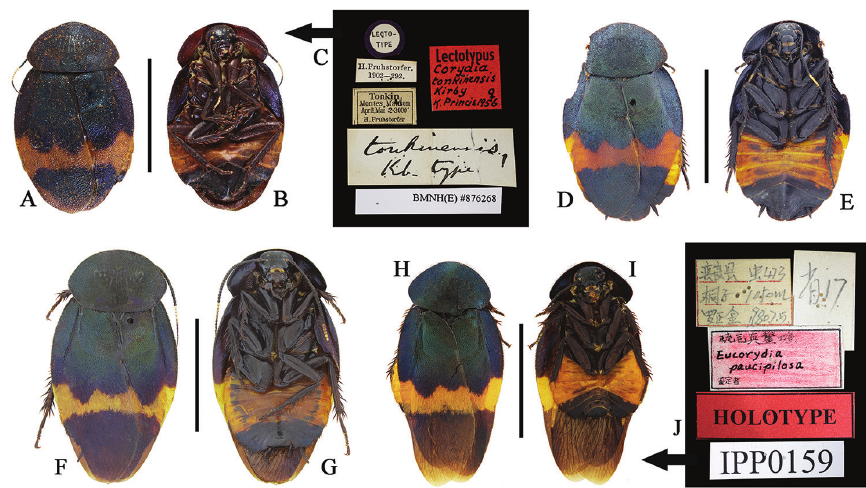
Figure 3. A–J Eucorydia dasytoides , the tonkinensis population A–C lectotype of Corydia tonkinensis : A–B habitus, female C label [A–C photographed by Zong-Qing Wang, copyright The Natural His- tory Museum, United Kingdom (NHM)] D–E female, from Jinxiu, Guangxi F–G male, from Jinxiu, Guangxi H–J holotype of Eucorydia paucipilosa : H–I habitus, male J label. Scale bars 10